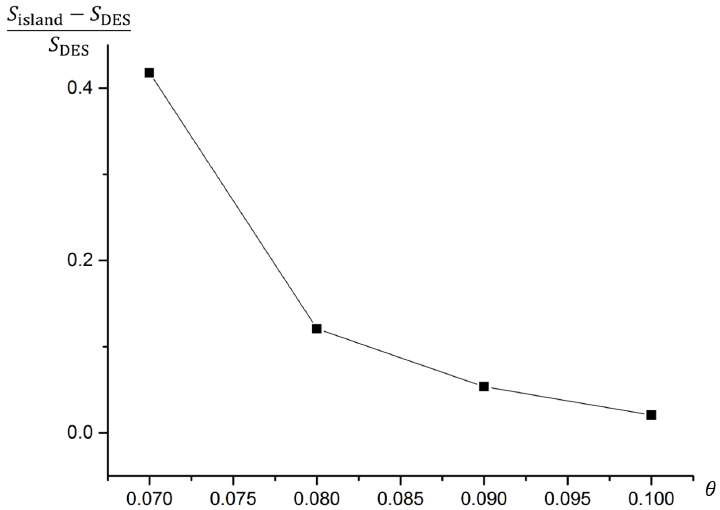
Figure 17 . Plot of the entropy difference divided by S DES . We pick 1 (cid:15) = 0 . 05